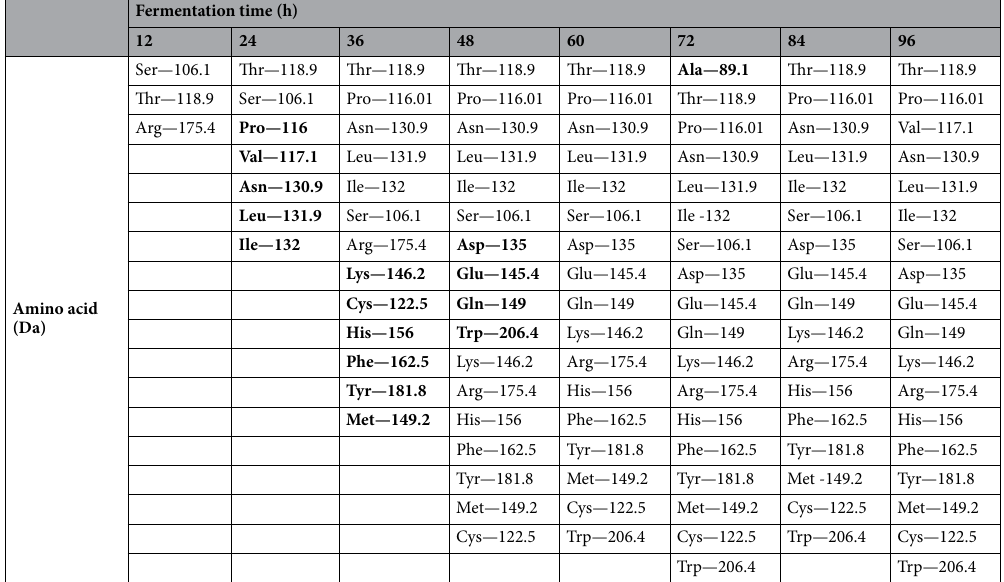
Table 2. Free amino acid composition of feather hydrolysate produced by B. velezensis NCIM 5802 at different time intervals as analyzed by ESI–MS. Significant values are given in